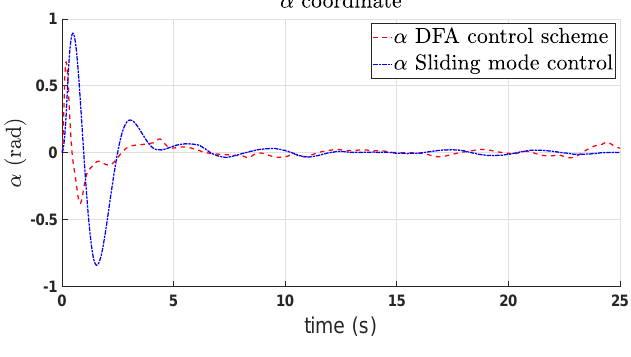
Figure 5. Behavior of α .